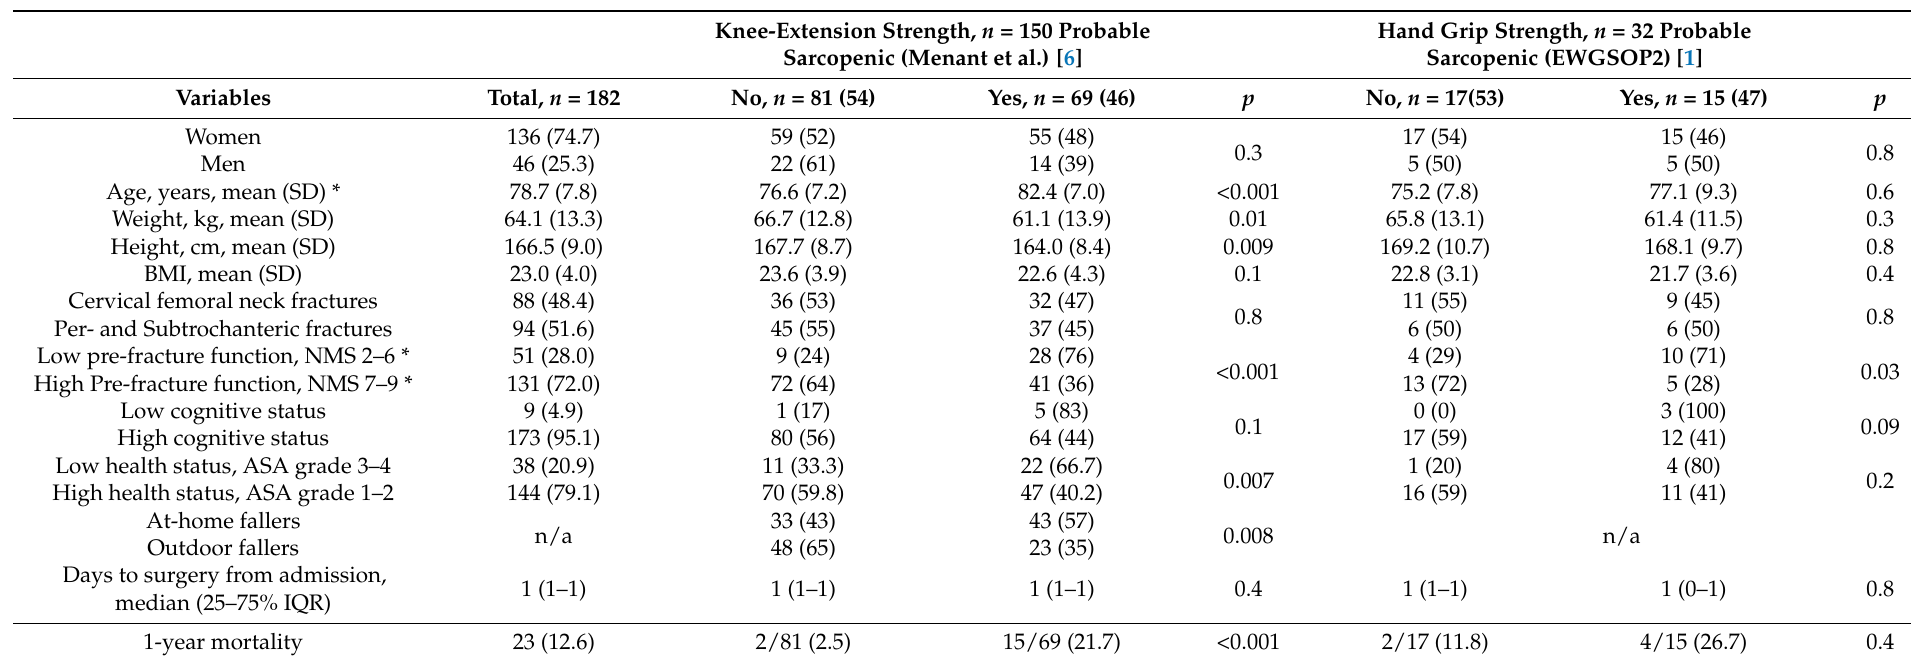
Table 1. Characteristics of patients with hip fracture according to sex-specific muscle strength cut-points of a probable sarcopenic status, n =